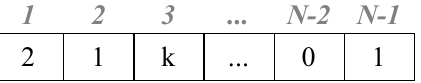
Figure 4. Codification to locate DGs and ESSs in distribution